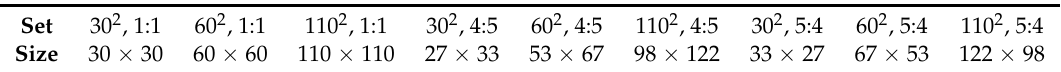
Table 1. Boundary box dimensions for nine candidate